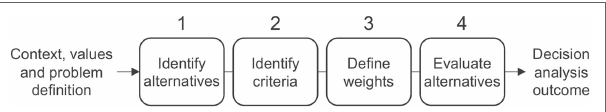
FiGURe 1 | Main steps involved in multicriteria decision analysis